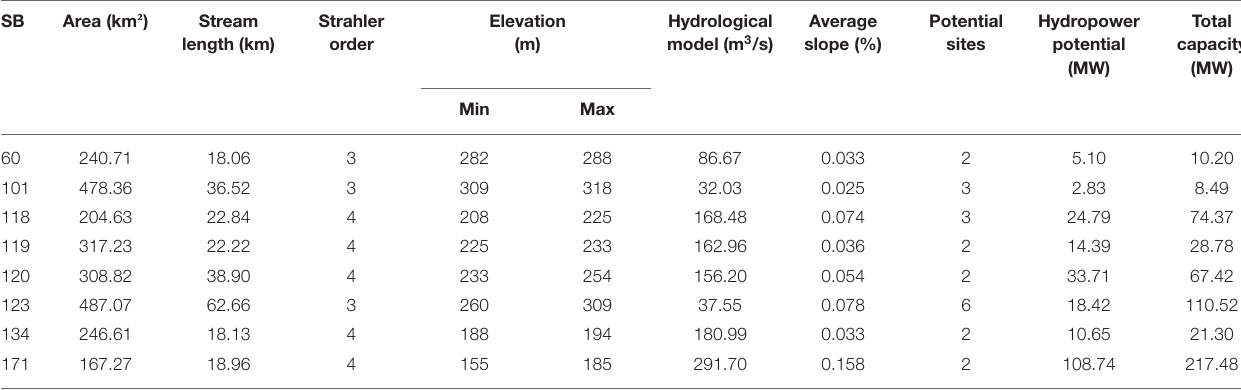
TABLE 4 | Distribution of the potentially exploitable sites by the